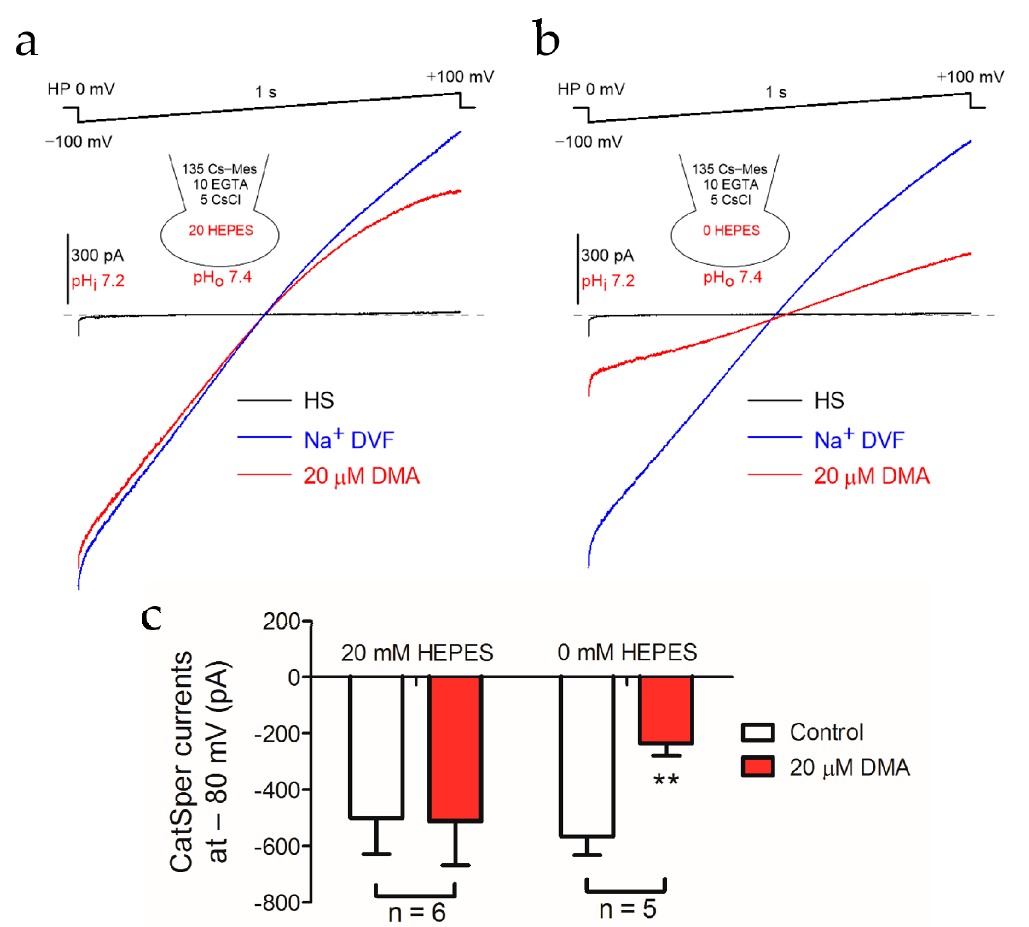
Figure 4. DMA prominently inhibited the Ca 2+ ion channel (CatSper) currents via the acidification of pH i . Representative patch-clamp recordings of CatSper currents in the absence or presence of 20 µ M DMA elicited by 1 s voltage ramp from − 100 mV to +100 mV with a 20 mM HEPES ( a ) or 0 mM HEPES ( b ) pipette solution at pH i 7.2. The sodium-based divalent free solution (Na + DVF) was employed to record the monovalent CatSper current and maintain NHEs activity. ( c ) Statistical analysis of the mean CatSper currents at − 80 mV recorded in the pipette solution containing 20 mM HEPES ( n = 6) or 0 mM HEPES ( n = 5). Data are expressed as mean ± SEM. ** p < 0.01 (paired t -test).